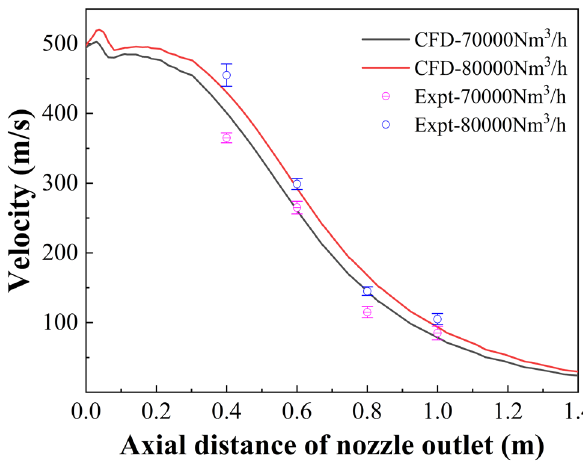
Figure 4: Comparison and veri fi cation of jet velocity distribution along the nozzle axis.